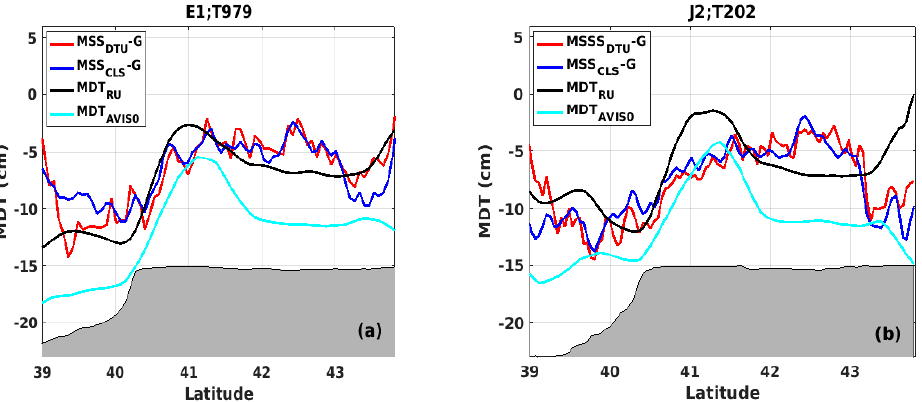
Figure 3. Derived mean dynamic topography (MDT) along ( a ) Envisat track E797 and ( b ) Jason track J202 from the western GoM across Georges Bank into the Atlantic slope region (Figure 2). Differing MDT estimates (see text) come from Mean Sea Surface (MSS) minus Geoid (G), either using MSS DTU [6] or MSS CLS [3] as well as from MDT AVISO [4] and MDT RU [48]. Grey areas depict the schematic bathymetry along these tracks. Note that the vertical offset between MDT RU and MDT AVISO is a matter of vertical datum but does not impact ocean dynamics.